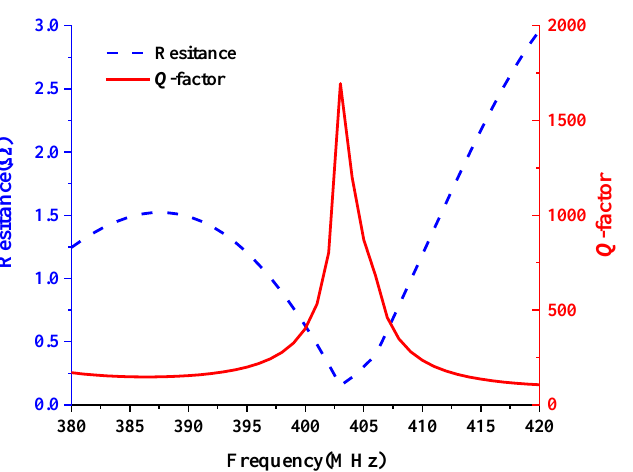
Figure 8. Simulated parasitic resistance and Q-factor of the optimised four-turn split-ring loop.